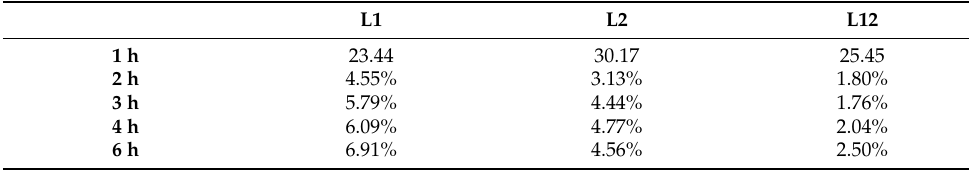
Table 7. Performance of dUT1 RMS values for 2, 3, 4, and 6 h resolutions with respect to 1 h resolution (increase in [%]). The 1 h values are provided in terms of their RMS values ( µ s), and the other sub-daily resolutions correspond to the improvement in